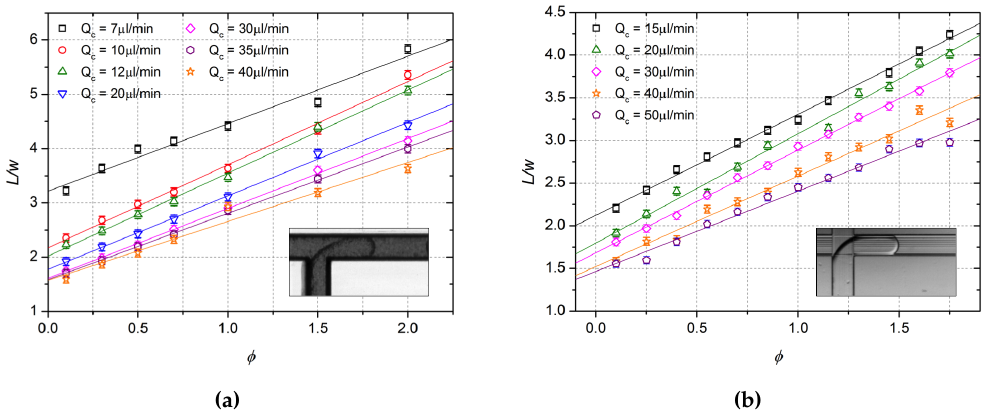
Figure 10. Dependence of the rescaled length L / w on the flow rate ratio at different values of the continuous phase flow rate Q c with the relative linear fit. the data obtained with the laser ablated T-junction ( a ); the data from the cross-junction engraved with the dicing saw ( b